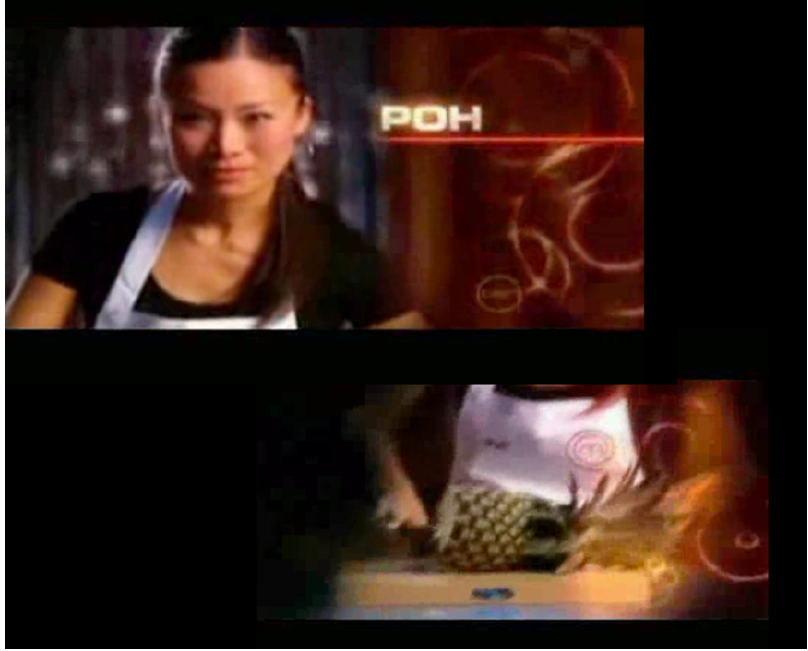
Figure 5. Poh Ling Yeow introduction